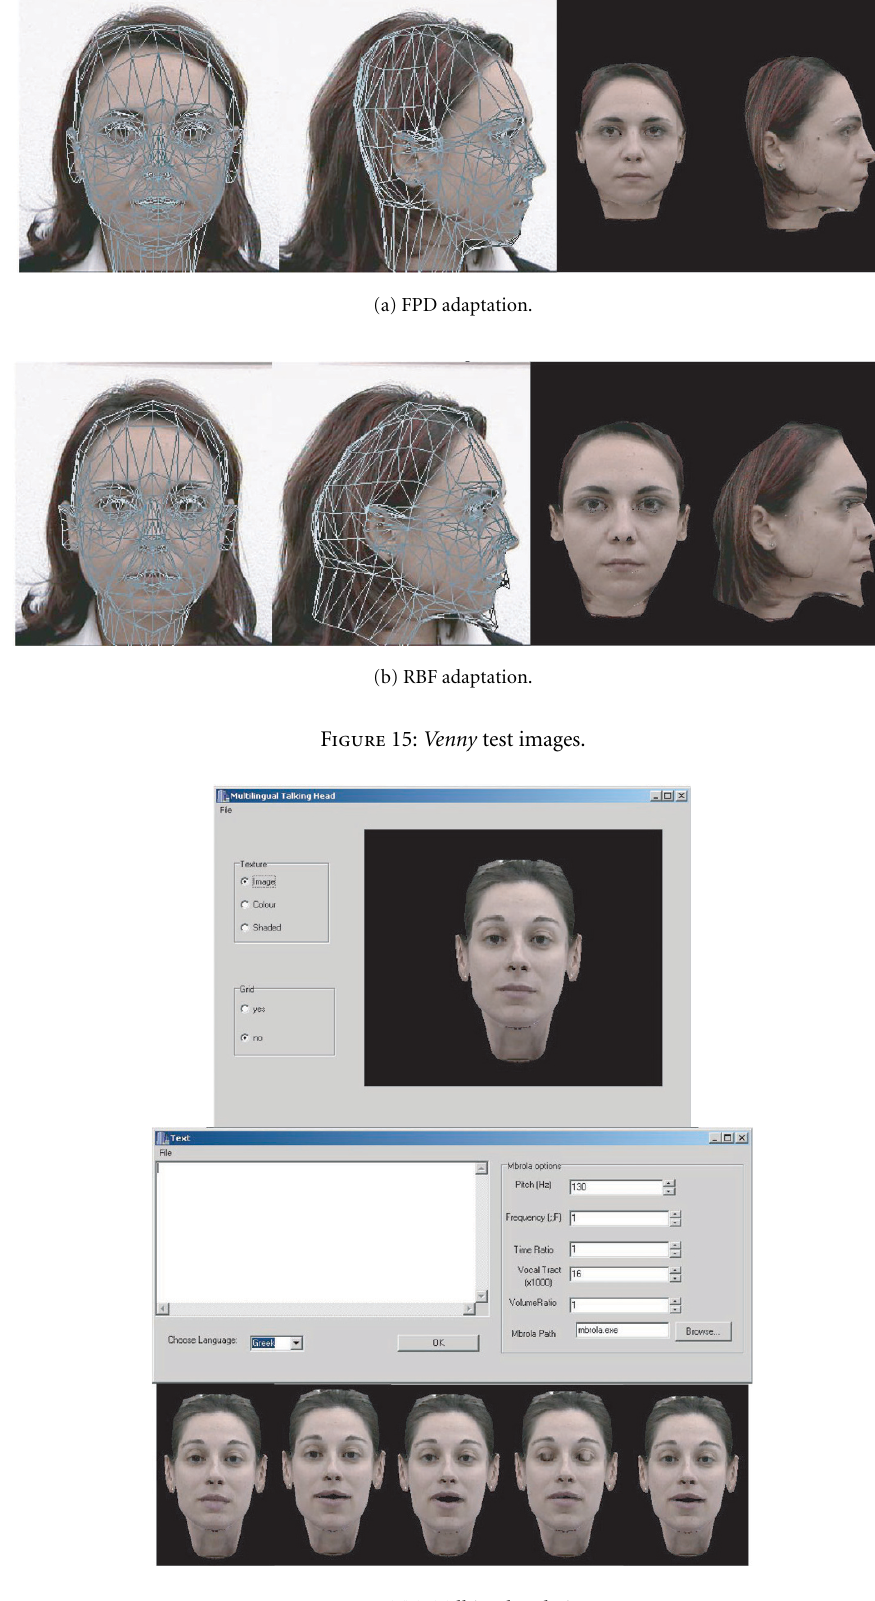
Figure 16: TTS Talking head